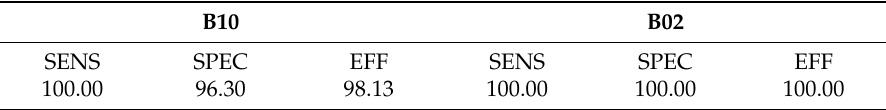
Table 8. PLS-DA classification results obtained in prediction on QEPAS spectra acquired for models validation in laboratory